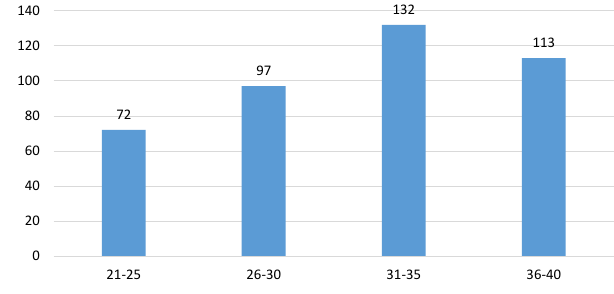
Figure 8. Depiction of respondents by age The range of age was found to be 19 years starting from 21 to 40 years. Nearly 17% are in range 21 to 25 years of age. There are 97 respondents aged 26 to 30 years. In term of age groups, the respondents aged 26 to 30 comprise 23% of the total and 36 to 40 years show 27% of the total. To be more specific, large number of respondents are in range 31 to 35 years of age in the